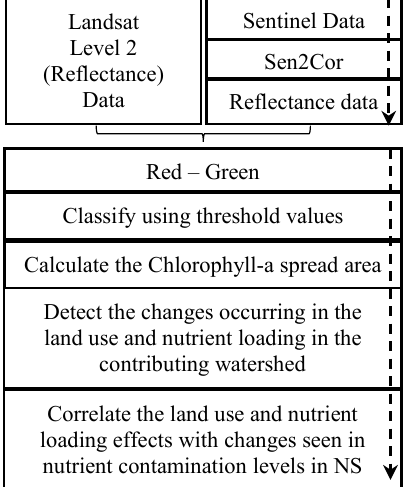
Figure 3: Flowchart showing the flow of the current